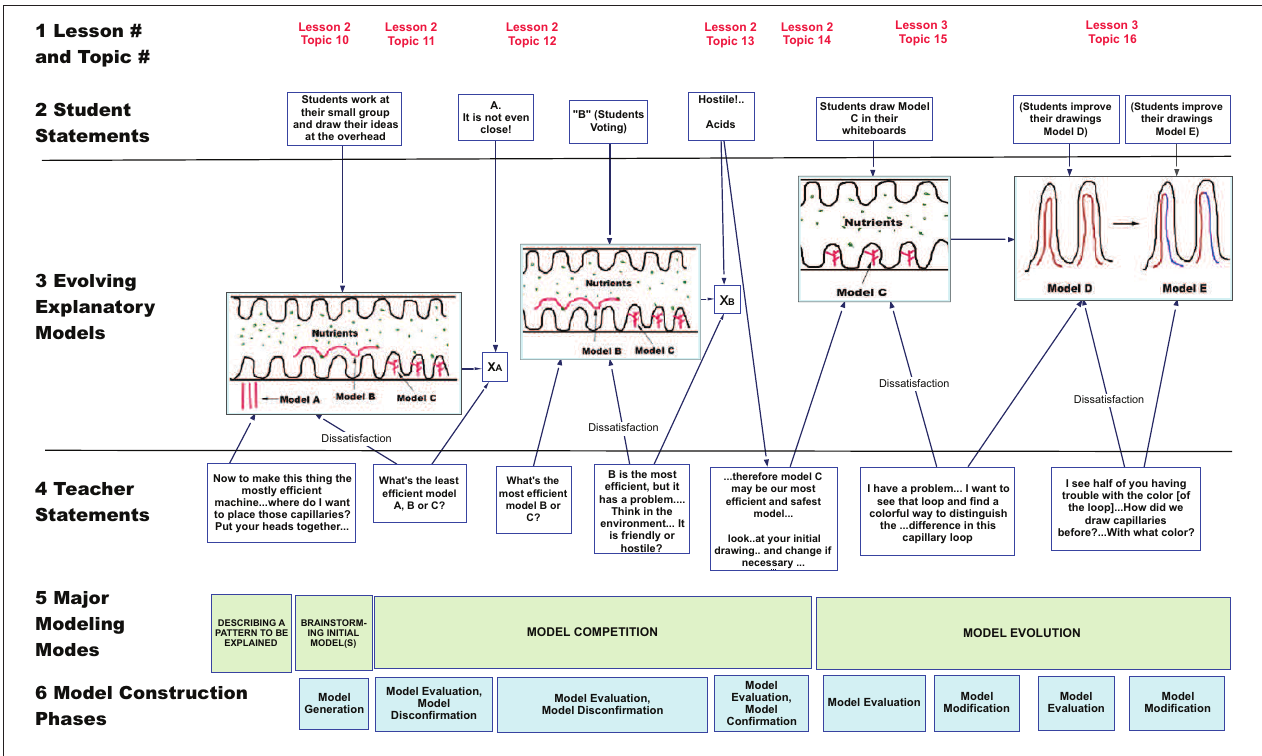
FIGURE 6 | Classroom dialogue